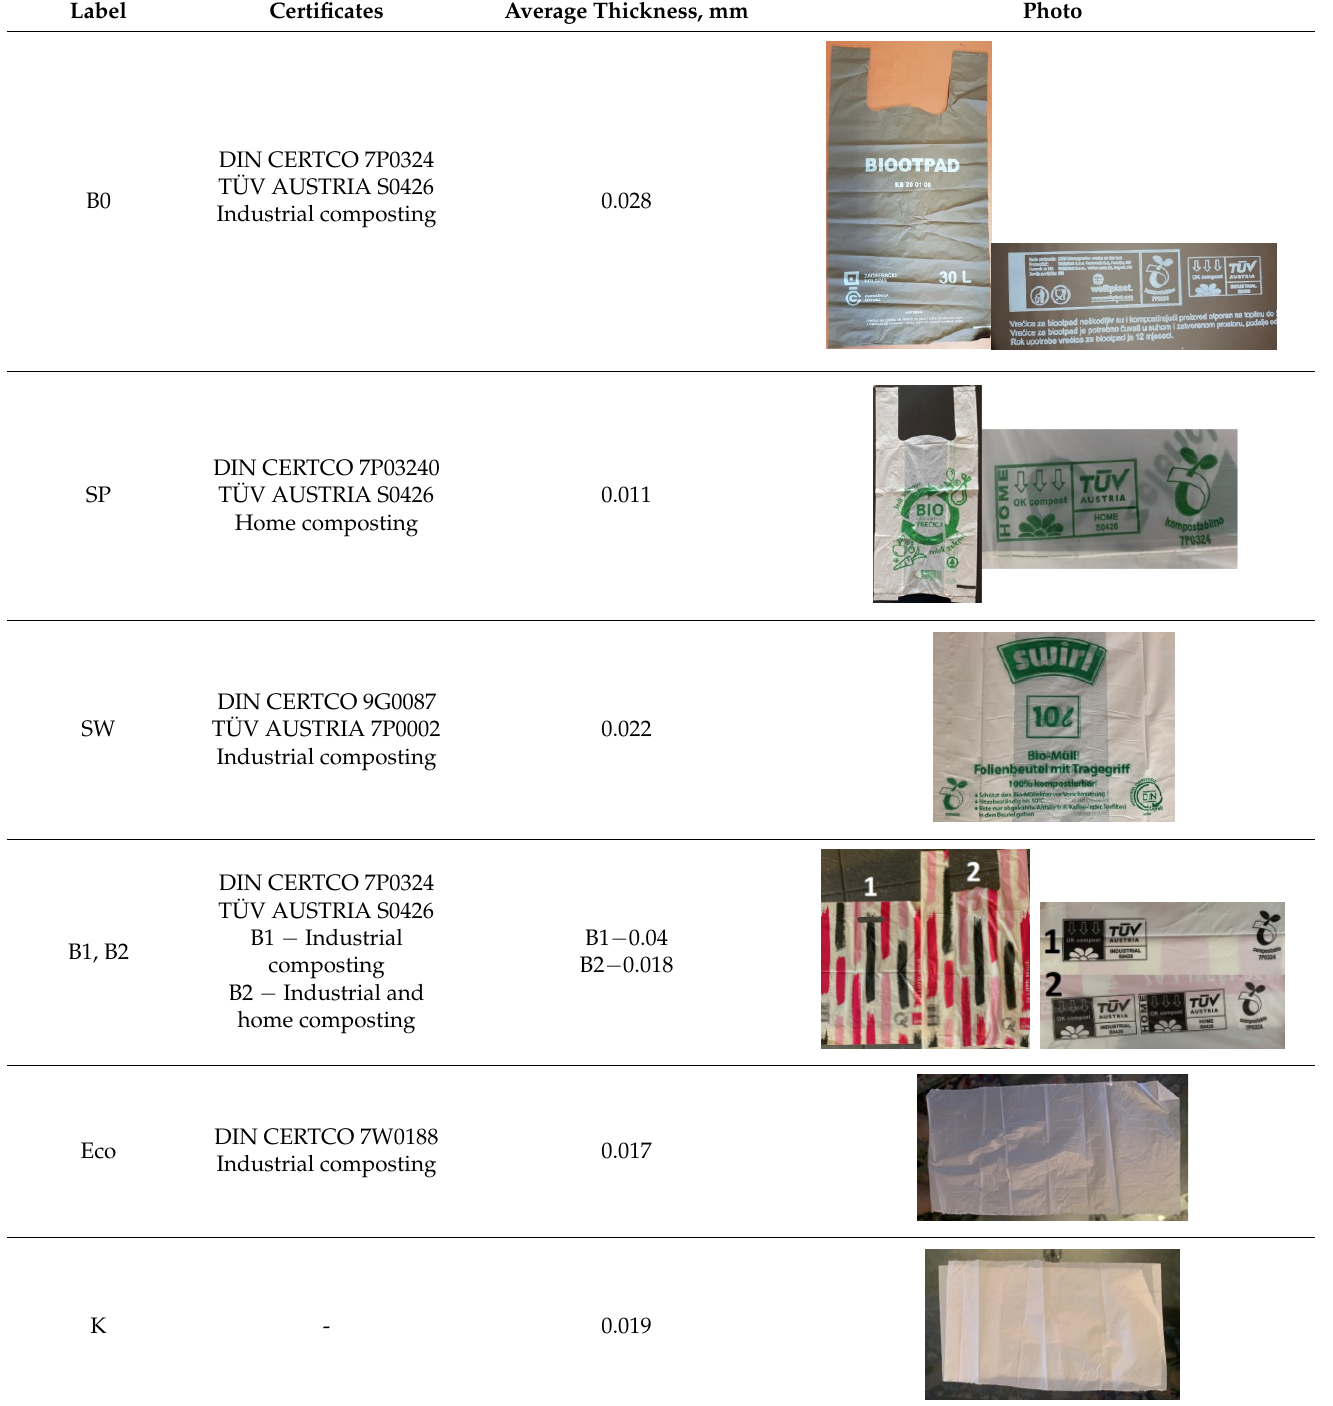
Table 1. Tested biodegradable films.